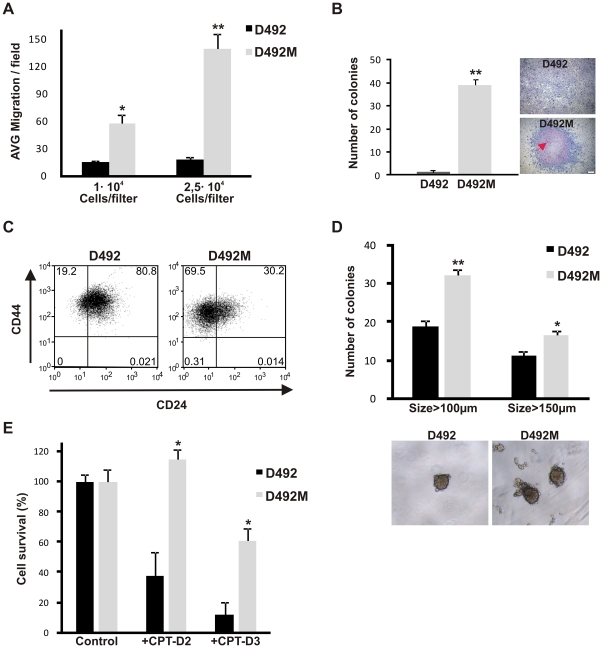
D492M has acquired cancer stem cell-like phenotype.
A, D492M show increased migration compared to D492. Increased migration was seen at the two cell concentrations (1×104 and 2.5×104). B, D492M grow anchorage independently. In 0.5% soft agar D492 cells fail to form colonies. In contrast, the D492M cells are able to grow, indicating acquisition of anchorage independent growth. In monolayer culture (right) D492 cells are contact inhibited while D492M piles up in the culture flask indicating lack of contact inhibition (arrows). Counterstain hematoxylin. Bar 100 µm. C, D492M cells are CD44high,CD24low consisting with the breast cancer stem cell phenotype. D492 contain a subpopulation (19%) of cells that are CD44high, CD24low. This population increases to 70% in the D492M cell line. D, D492 and D492M differ in their ability to form mammospheres. Both D492 and D492M can generate colonies in mammosphere assay, however, D492M generates more and larger (>100 µm: 1.7 fold; >150 µm:1.5 fold) mammospheres than D492 cells. E, D492M cells show delayed chemically induced apoptosis. D492 and D492M show distinct responses to Camptothecin, an apoptosis inducing agent. D492 cells underwent immediate apoptosis and showed cell survival under 40% on day 2 while having no effect on D492M. On day 3 D492M cells showed cell survival of 60% where only few D492 cells were left. Data shown as AVG number of cells per field (A,E) or AVG number of colonies (B,D) +SEM in three experiments. *p<0.05; **p<0.01.